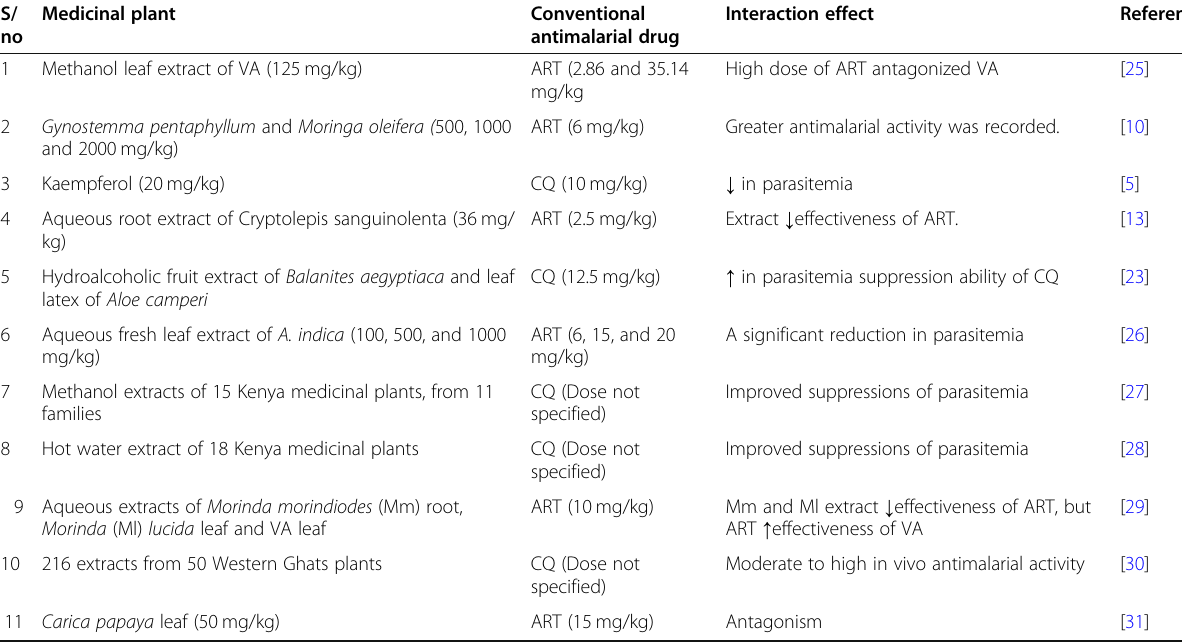
Table 1 Summary of studies on herbal-antimalarial drugs interactions using P. berghei model S/ Medicinal plant no